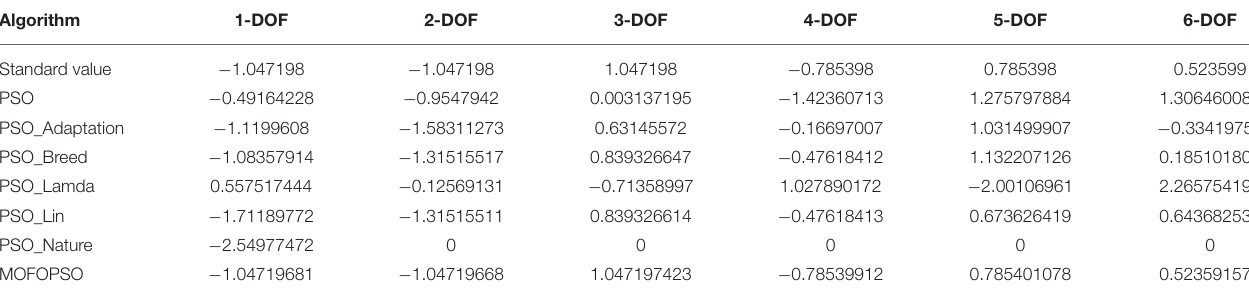
TABLE 6 | The angle values of the six joints of the manipulator calculated by different